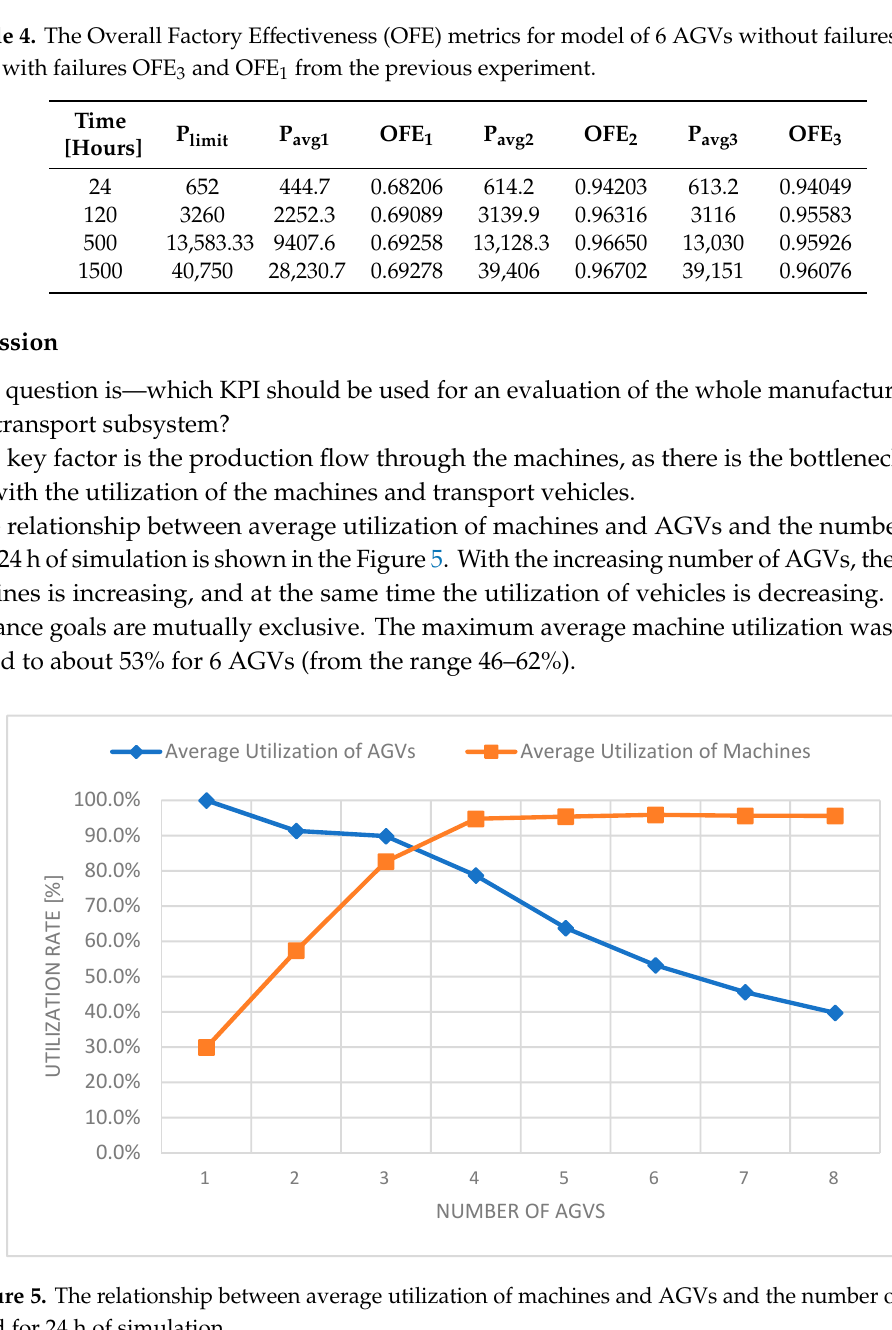
Table 5. OTE—Overall Transport Effectiveness and OFE—Overall Factory Effectiveness (24 h of simulation, 30 simulation runs in each experiment, without failures and battery charging). Nr of AGVs N agv